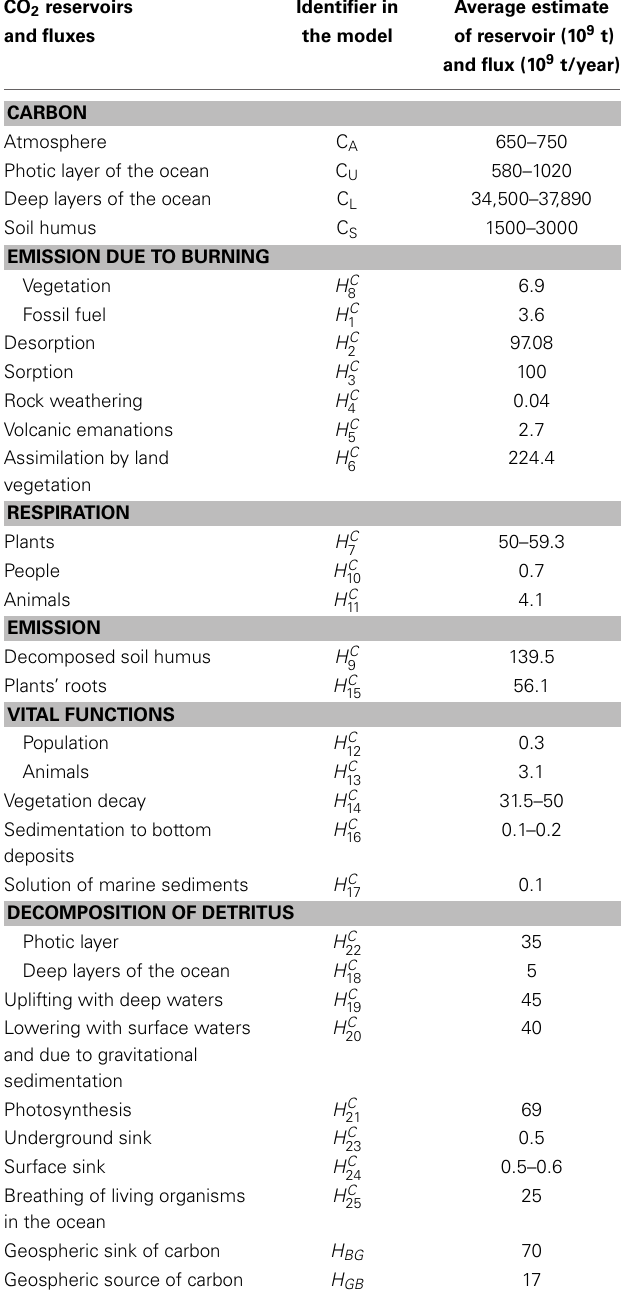
Table 1 | Model of global CO 2 cycle (MGCDC): Carbon reservoirs